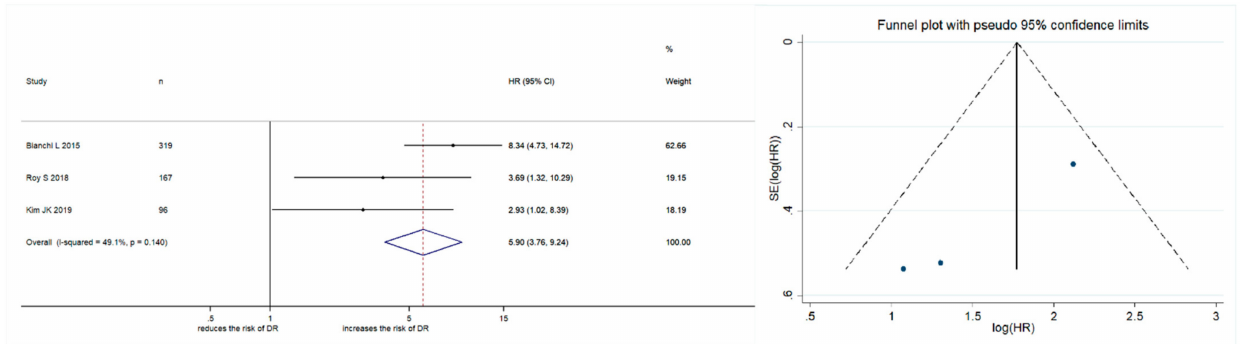
Figure 3. Forest plot and funnel plot showing the association of PSA persistence with disease recurrence in prostate cancer patients with pathological lymph nodal involvement at radical